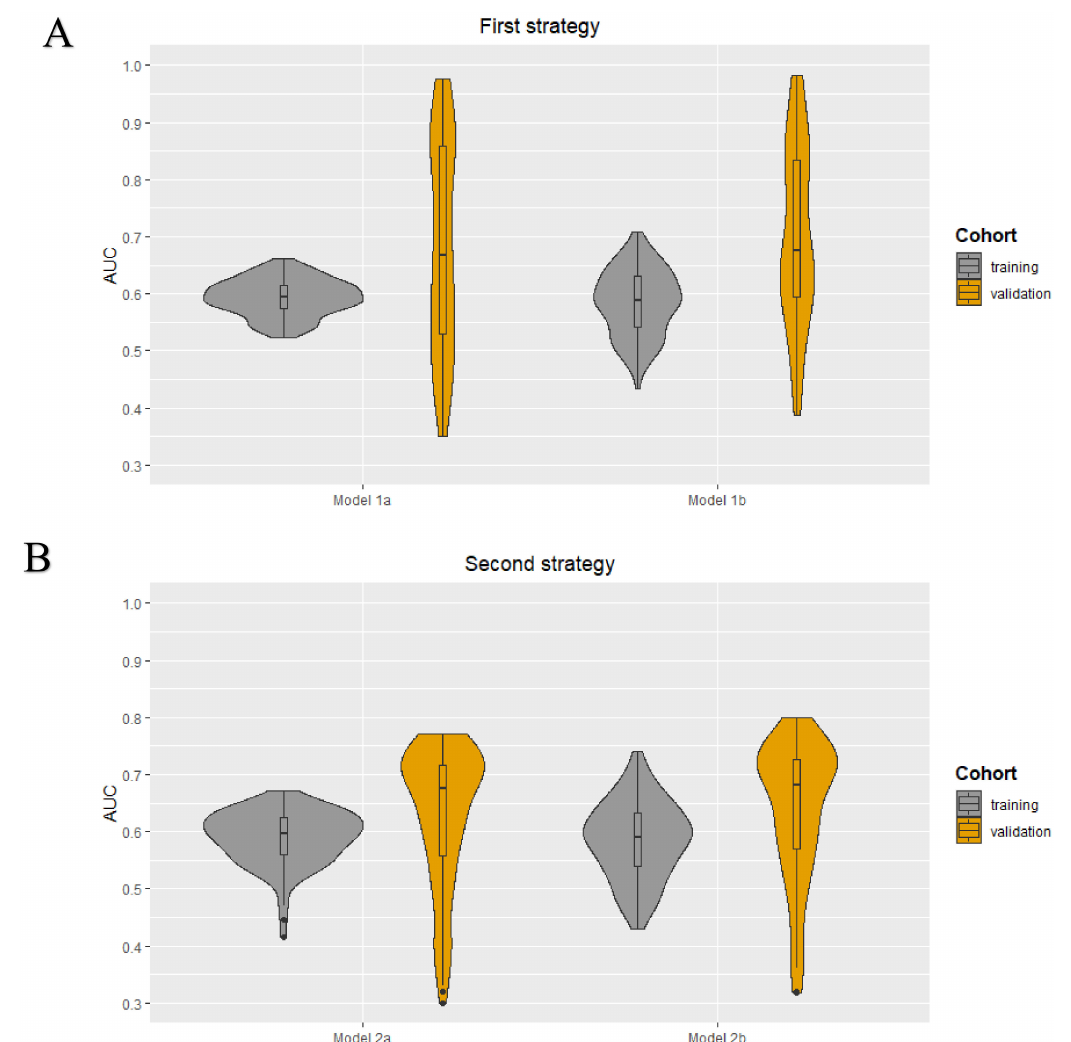
Figure 3. Violin plots for the clinical models developed using the first ( A ) and second ( B ) strategy: AUC value distributions (100 iterations) for the four models (1a, 1b, 2a, and 2b) in both the training and validation cohort. Table 3. The diagnostic performance of the clinical models (100 iterations) for the first and second strategy. Diagnostic